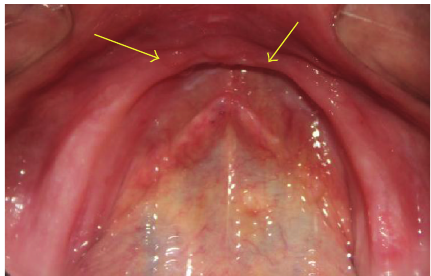
Figure 2: edentulous mandibular arch with arrows showing areas of flabby